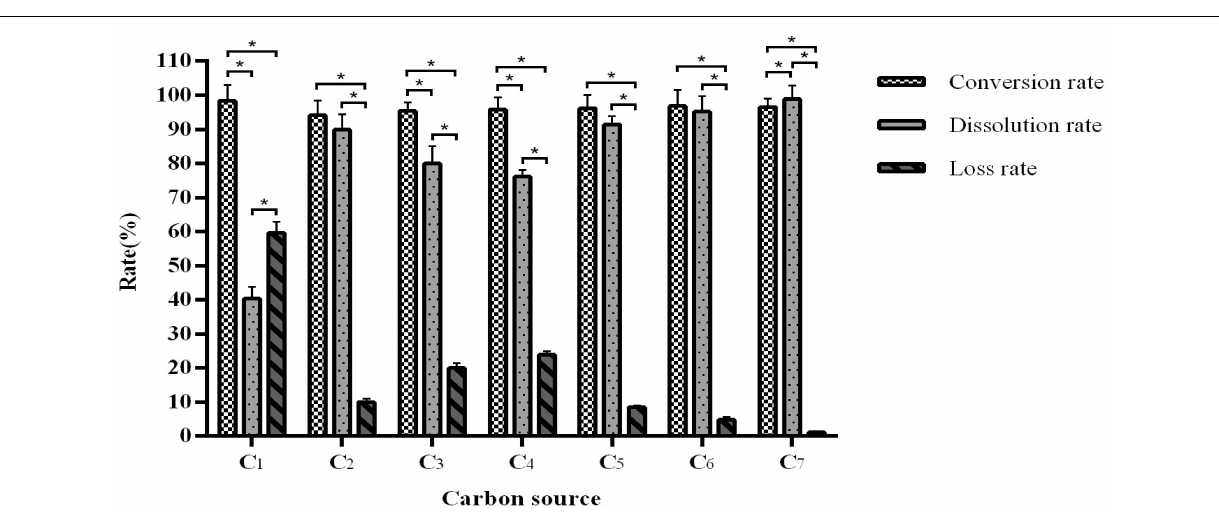
FIGURE 2 | The influence of the carbon source on fermentation efficiency. *Indicates significance at the 0.01